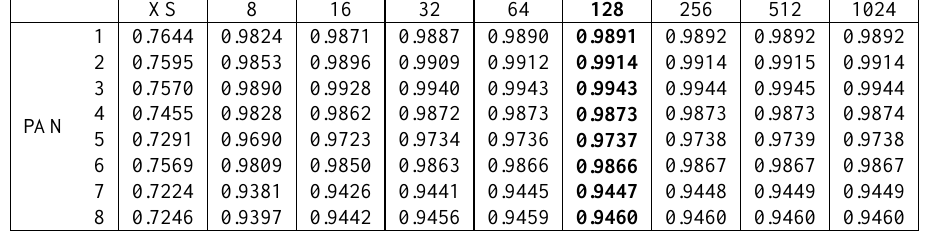
Table 3. LCC between Worldview-2 panchromatic and fused images using BR with different block size